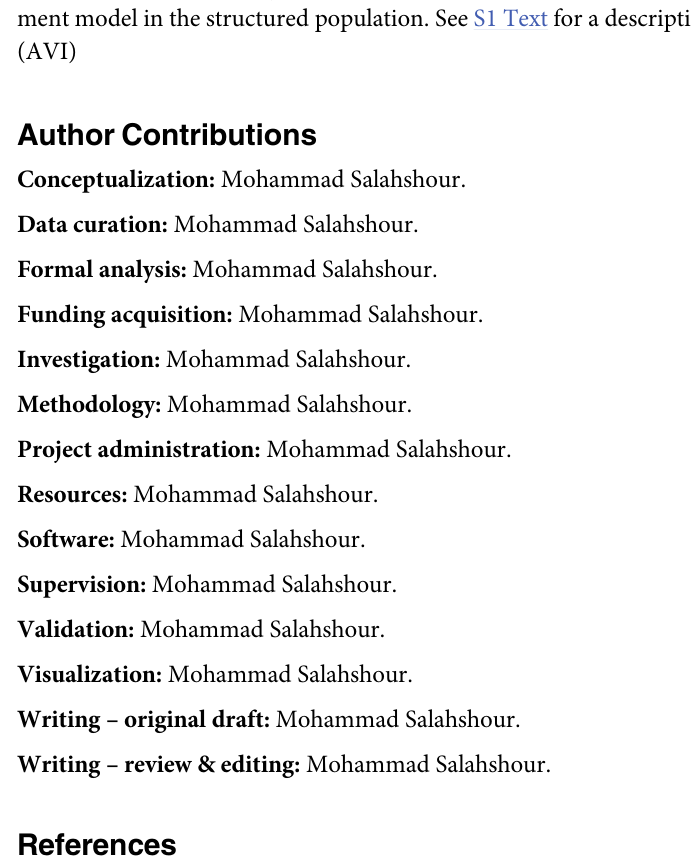
S3 Video. Supplementary video 3. An example of the time evolution of the wasteful punish- ment model in the structured population. See S1 Text for a description of video. (AVI) S4 Video. Supplementary video 4. An example of the time evolution of the wasteful punish- ment model in the structured population. See S1 Text for a description of video. (AVI) S5 Video. Supplementary video 5. An example of the time evolution of the wasteful punish- ment model in the structured population. See S1 Text for a description of video.